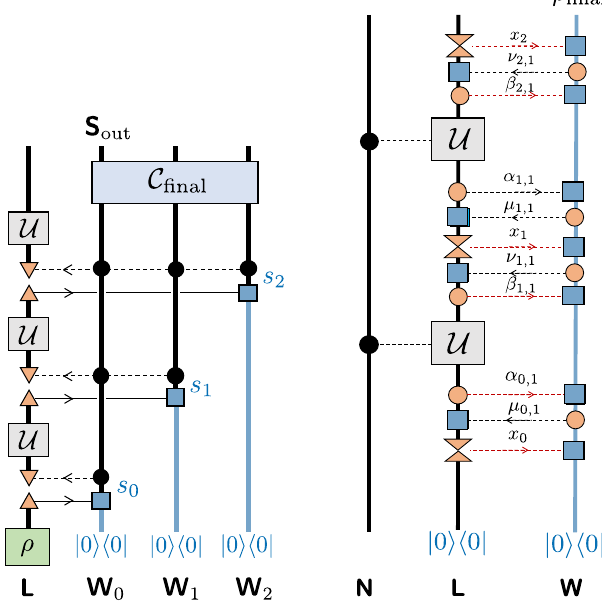
! h y s j ρ j y s i λ s . L L 0 ;::: s i 0 ;:::; s i 0 ;:::; s i controlled by 0 ;:::; s i